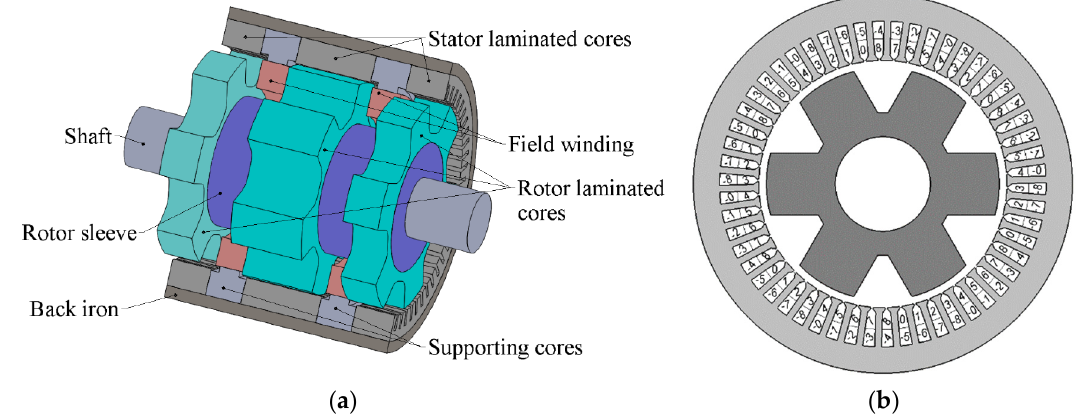
Figure 1. ( a ) Sketch of the SHM design. Armature winding is not shown to avoid cluttering; ( b ) sketch of the SHM cross-section.